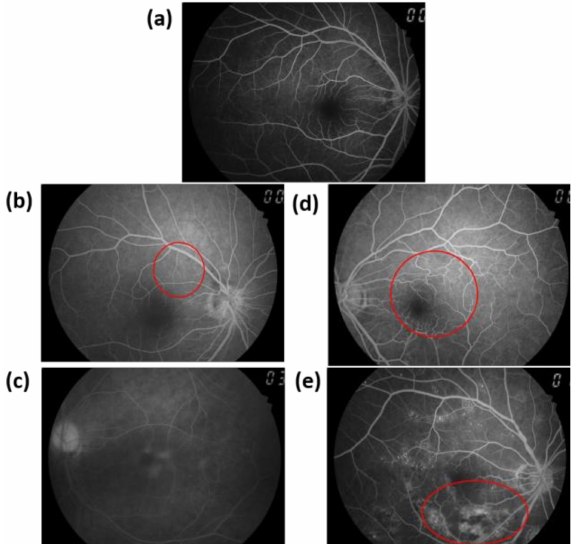
Figure 1. Fluorescein angiography (FA) images of ( a ) Normal, ( b ) background diabetic retinopathy (BDR), ( c ) pre-proliferative diabetic retinopathy (PPDR), and ( d ) early red proliferative diabetic retinopathy (PDR) highlights neovascularization at the red round frame ( e ). The red circle frame is late PDR because it shows a stain that leaks from the new vascular tissue and is shown as high